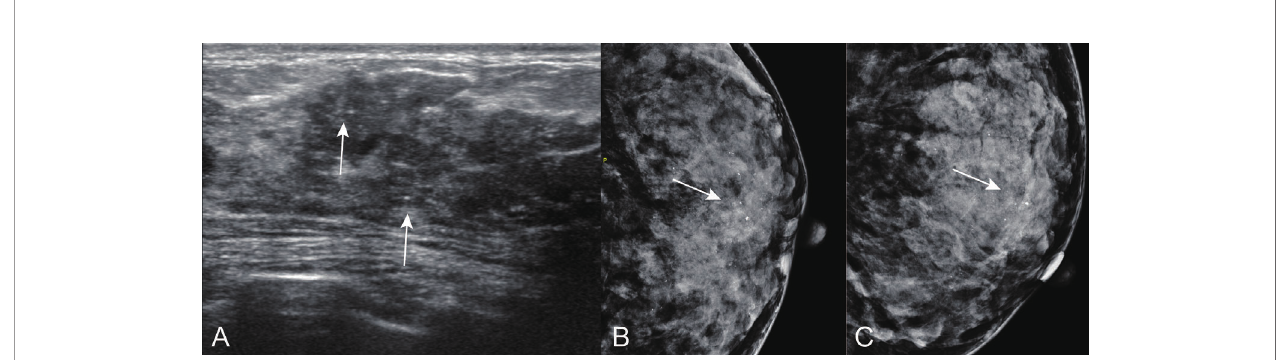
FIGURE 6 | Calci fi cations on US in patients with ADH on CNB. A 44 years old woman diagnosed with sclerosing adenosis at fi nal pathologic examination. (A) US showed sparse calci fi cations (arrow) at hypoechoic hypoechoic non-mass of breast lesion. Corresponding mammogram showed regional microcalci fi cations in CC position (B) and MLO position (C) .